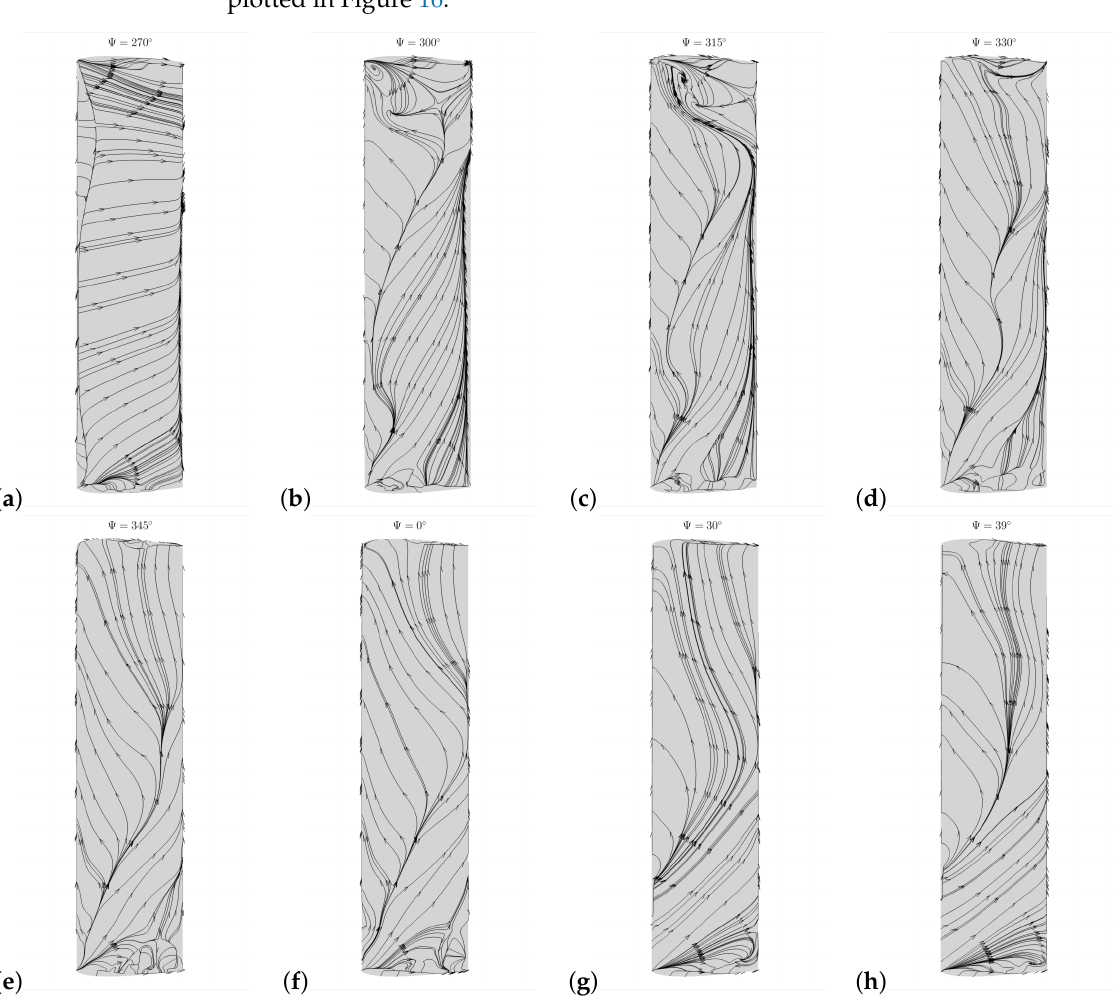
Figure 13. Snapshots of the skin friction lines c f . For each subplot, the blade is placed the same way as in Figure 8, with the top side being blade tip and bottom being blade root, the left side being the blade leading edge, and the right side being the trailing edge. Azimuth positions are: Ψ = ( a ) 270 ◦ ( b ) 300 ◦ ( c ) 315 ◦ ( d ) 330 ◦ ( e ) 345 ◦ ( f ) 0 ◦ ( g ) 30 ◦ ( h ) 39 ◦